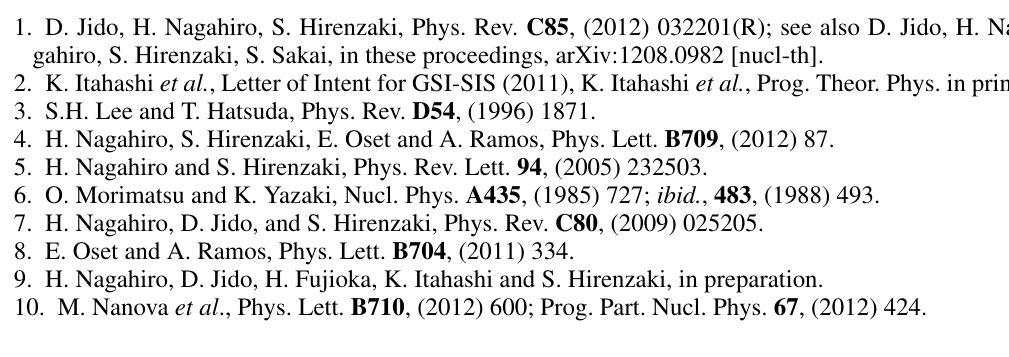
Fig. 2. Calculated spectra of 12 C( p ; d ) 11 C (cid:10) (cid:17) 0 reaction for the formation of the (cid:17) 0 -nucleus systems with the proton kinetic energy T p = 2 : 5 GeV and the deuteron angle (cid:18) d = 0 (cid:14) as functions of the excited energy E ex [9]. E 0 is the (cid:17) 0 production threshold. The (cid:17) 0 -nucleus optical potential are (a) ( V (c) (cid:0) (150 ; 15) MeV, and (d) (cid:0) (150 ; 20) MeV. The thick solid lines show the total spectra and dashed lines indicate subcomponents. The neutron-hole states are indicated as ( n ‘ j ) (cid:0) 1 potential of the (cid:17) 0 -nucleus system by the ( p ; d ) reaction with 12 C targets. The conversion spectra